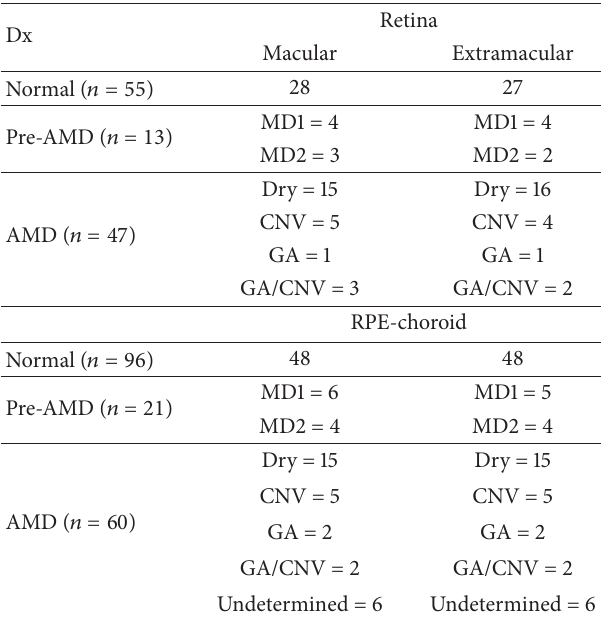
Table 2: The study collection’s clinical phenotypes and the number of their specimens. Data source: GSE29801 at Geo Datasets of